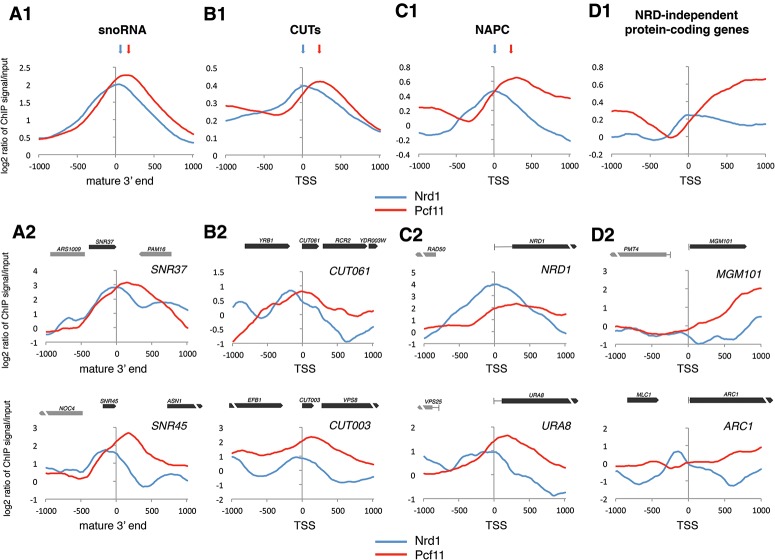
Differential localization of Nrd1 and Pcf11 over NRD terminators. (A1,B1,C1,D1) Metagene analysis of Nrd1 and Pcf11 recruitment relative to the mature 3′ ends of independently transcribed snoRNA (A1), CUT TSSs (B1), NAPC gene TSSs (C1), or Nrd1-independent protein-coding gene TSSs (D1). Blue and red arrows indicate the maximum signal for Nrd1 or Pcf11, respectively. (A2,B2,C2,D2) Pcf11 and Nrd1 recruitment over single genes. The X-axis marks the snoRNA mature 3′ end or either CUT or protein-coding gene TSSs. Plots are ChIP–chip signals smoothed with a 220-nt moving average.